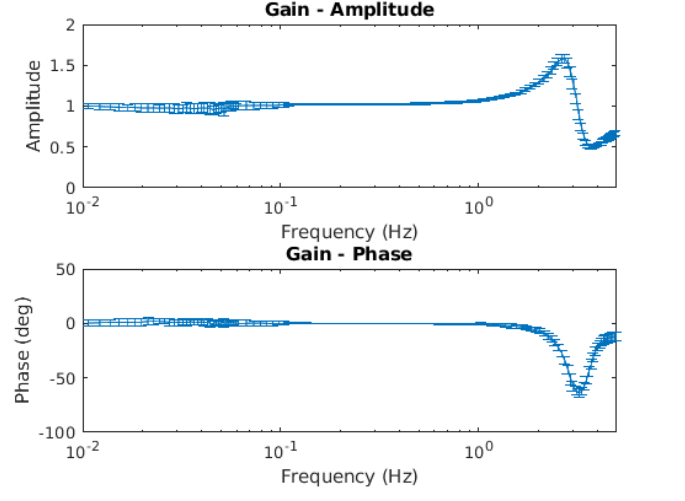
Figure 7. The same as Figure 6 but for a defective WNRS with one-quarter of the inlets